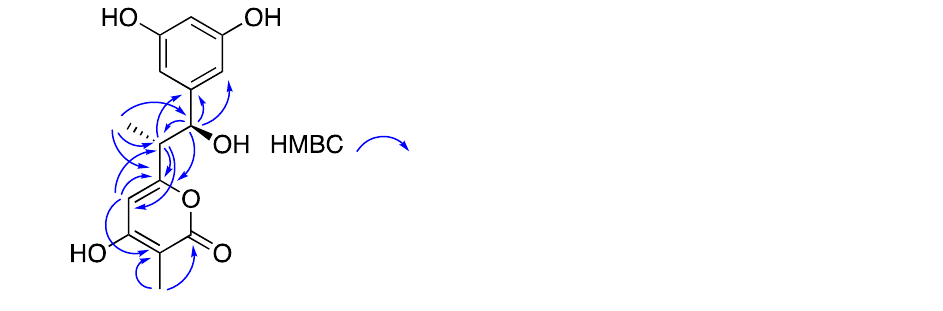
Figure 2. Selected HMBC correlations observed for salinorcinol ( 3 ) .